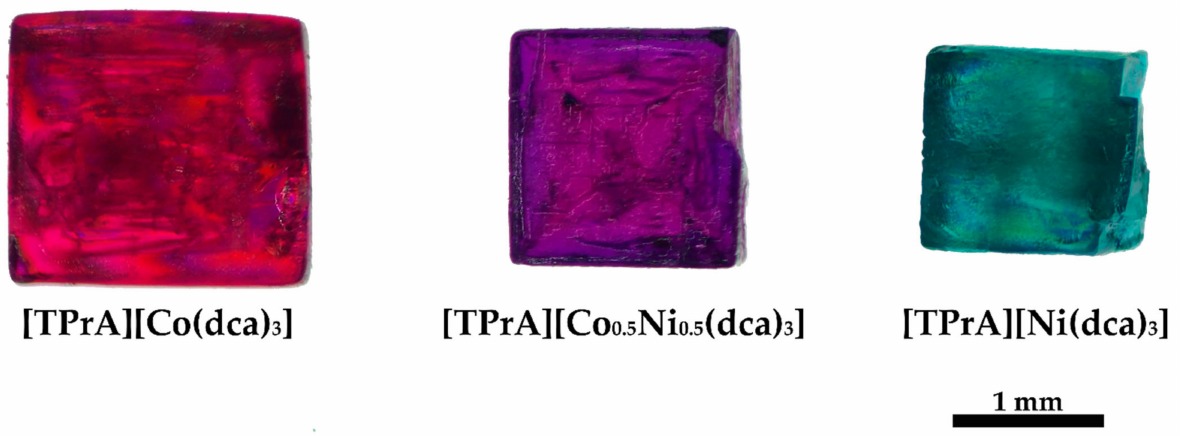
Figure 1. Cubic single crystals of [TPrA][Co x Ni 1 − x (dca) 3 ], where x = 1.0, 0.5 and